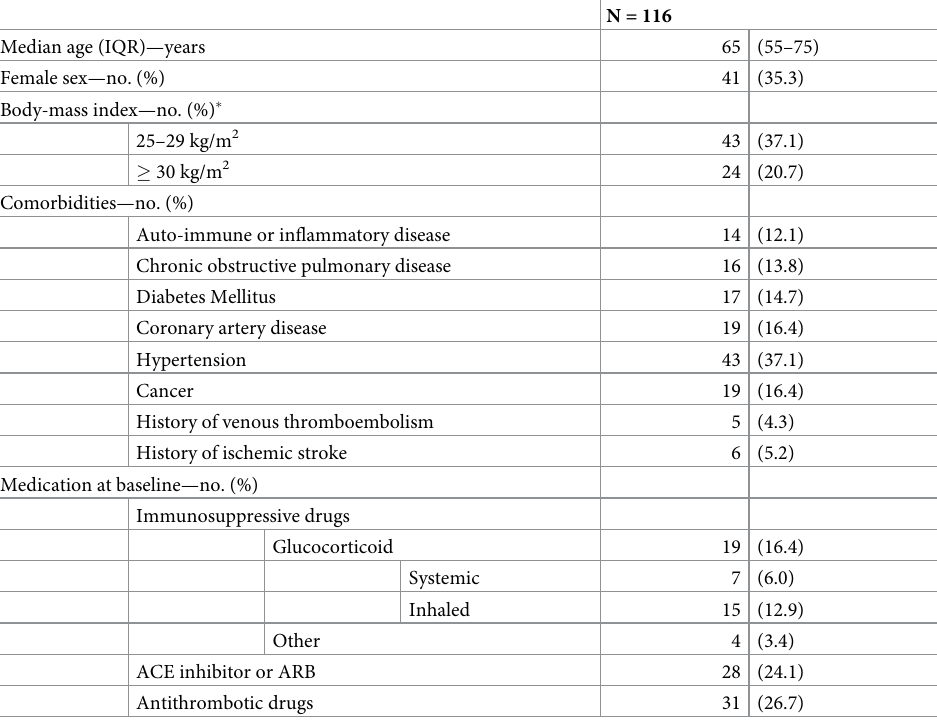
Table 2. Baseline patient characteristics and outcomes.